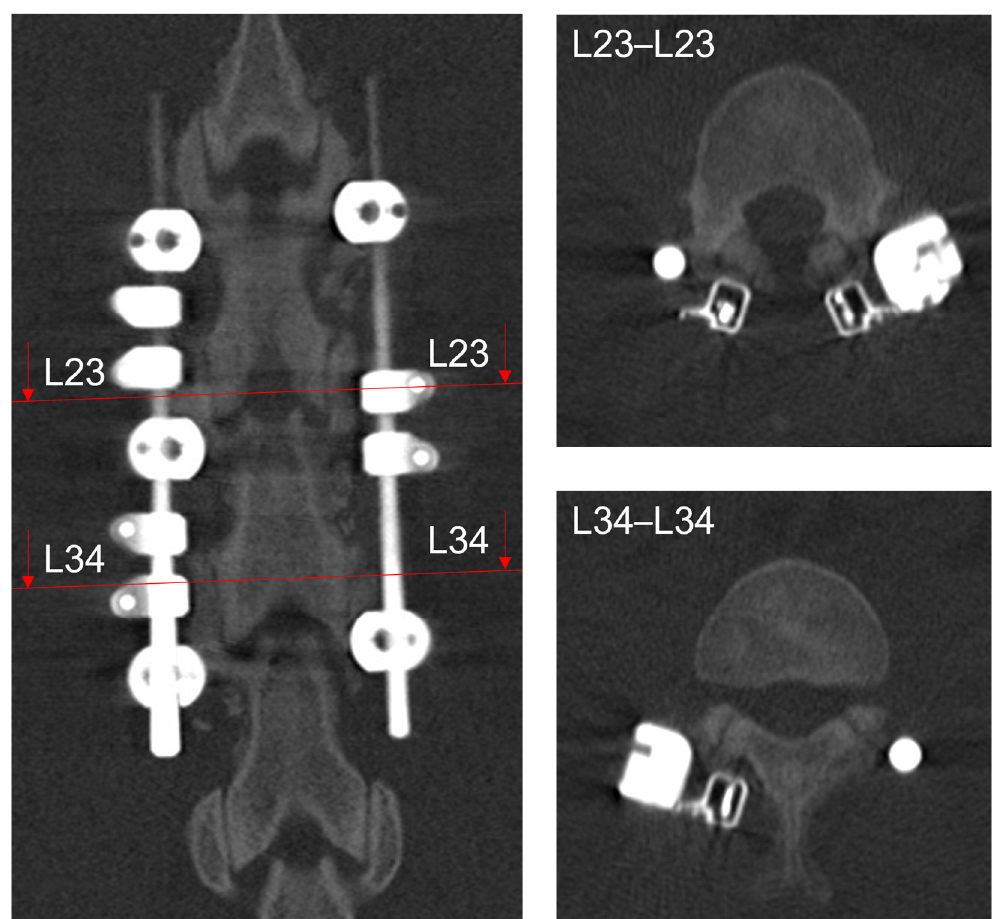
Figure 5. Sections of the eight-week clinical CT scan. Posterior-anterior view of operated spine ( left ) with section lines for cranial-caudal slices of the operated segments L23 and L34 illustrated on the right .